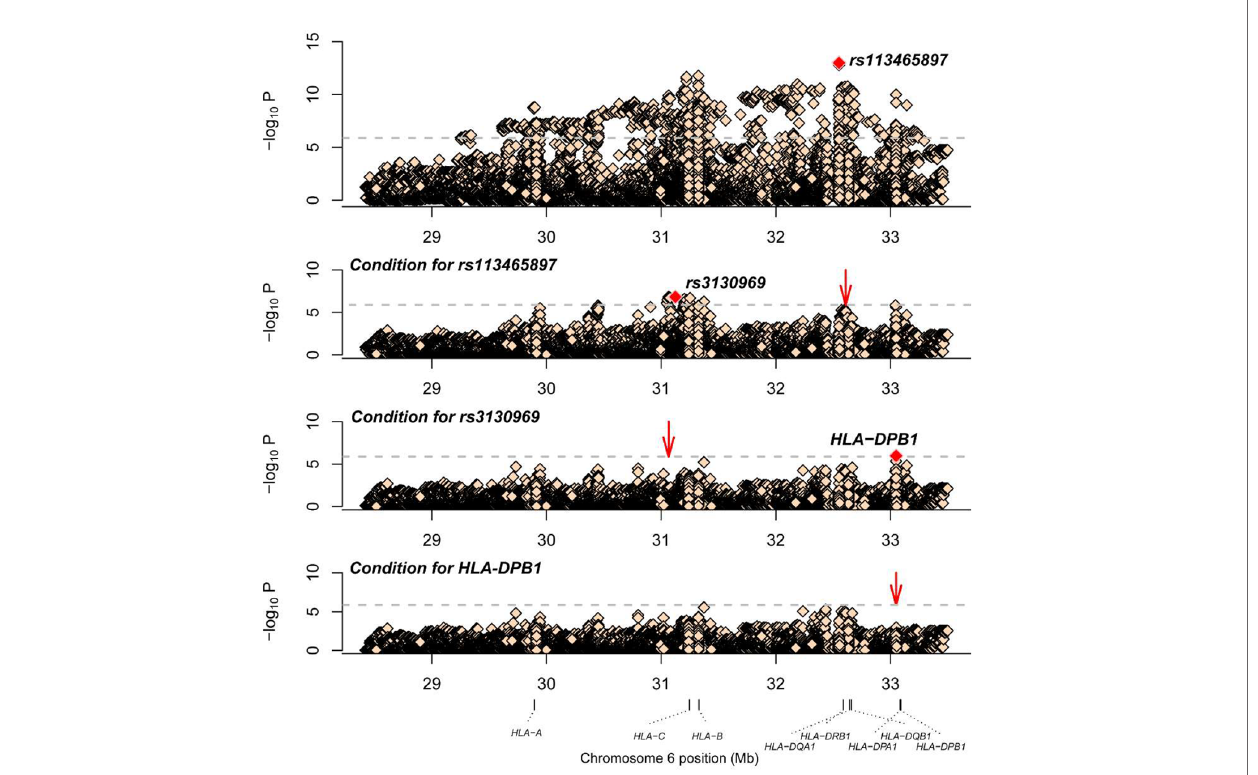
FIGURE 1 | Association plots of stepwise conditional analysis for HLA alleles and SNPs for vitiligo. The abscissa represents genomic loci, and the ordinate represents the -log10(p) of association analysis for each locus. The horizontal line represents the signi fi cance threshold P=1.32×10 – 6 . The dots marked red in each panel represent the sites used for condition analysis (rs113465897, rs3130969 and HLA-DPB1*0301).